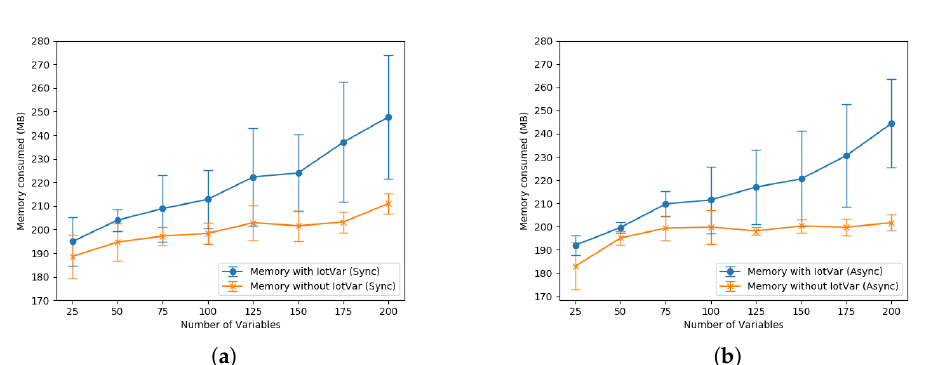
Figure 7. Memory usage for ( a ) a synchronous handling and ( b ) a publish-subscribe handling.